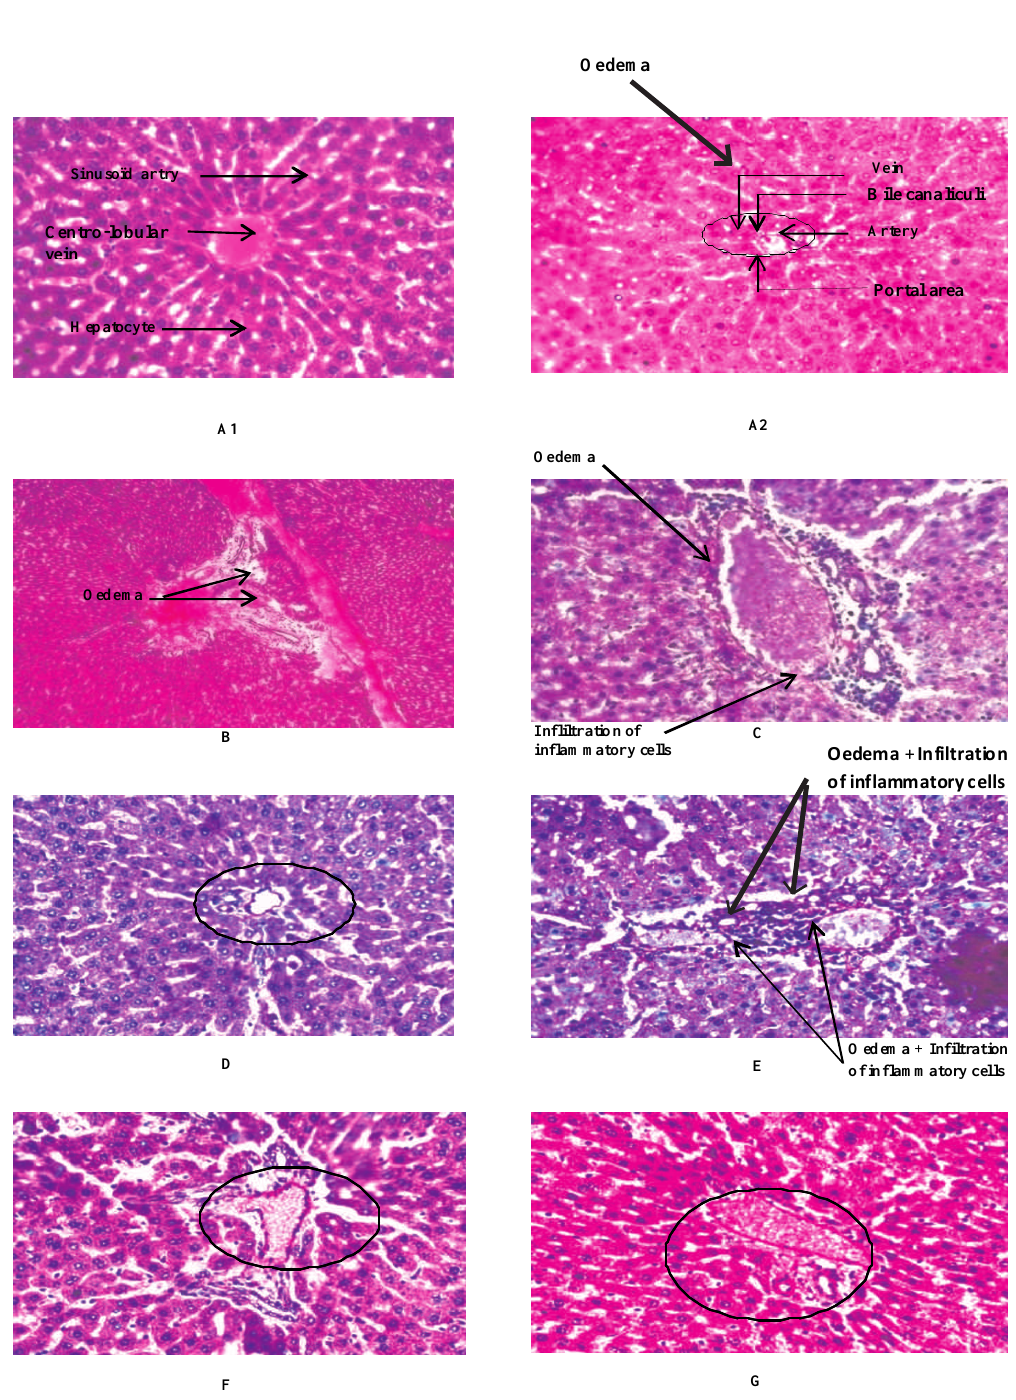
Figure 1. Effect of Nigella sativa extract on liver tissue, Histology of liver tissues from normal rats (A1&A2), untreated diabetic rats (B); diabetic rats treated (for 17 days) with total Nigella sativa seeds oil at100mg/kg/day (C), lipid polar (D) and neutral (E) fractions from total Nigella sativa seeds oil at100mg/kg bw/day; thymo- quinone at 25 mg/kg bw/day (F) and metformin at 25 mg/kg bw/day (G). Diabetes was induced by N/STZ. Magnification (X425) Slides are stained with haematoxylin and eosin